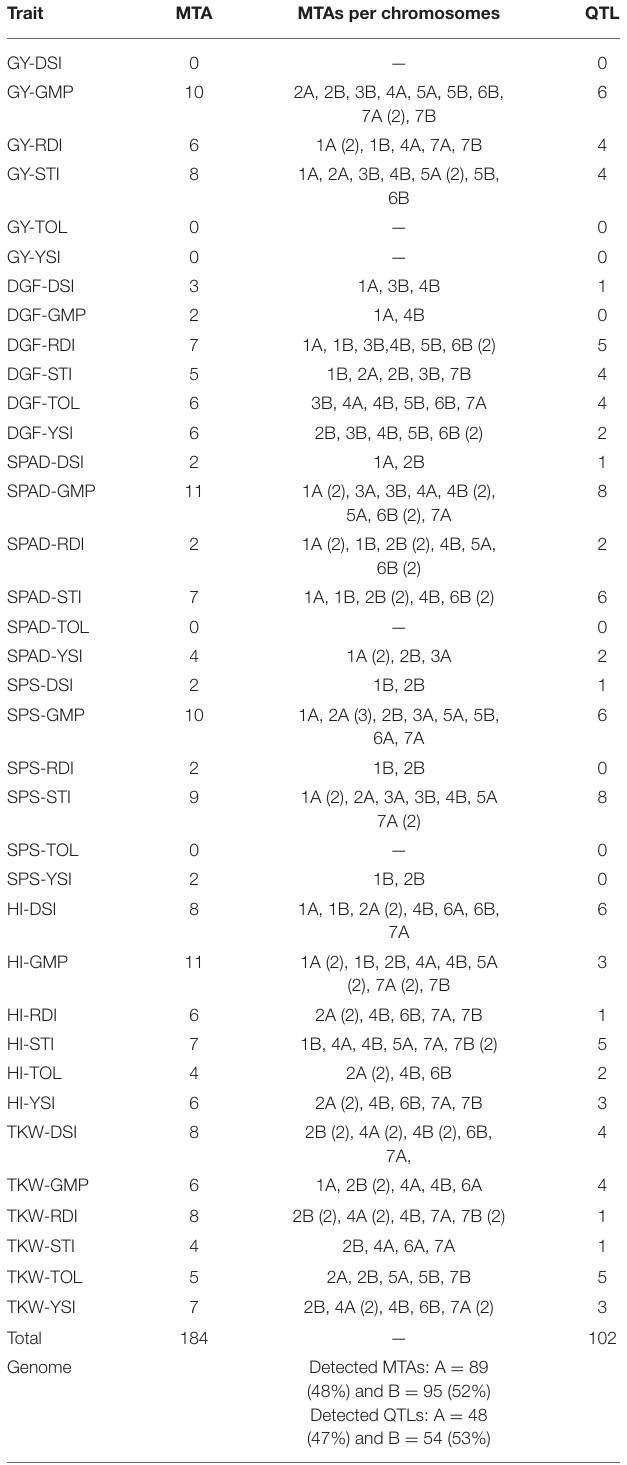
TABLE 3 | Significant (–log 10 p 4.0) marker-trait associations (MTAs) and ≥ quantitative trait loci (QTL) that were detected for the drought indices traits calculated from grain yield and traits significantly ( p < 0.001) positively correlated with grain yield under FNS and FDS. Trait MTA MTAs per chromosomes